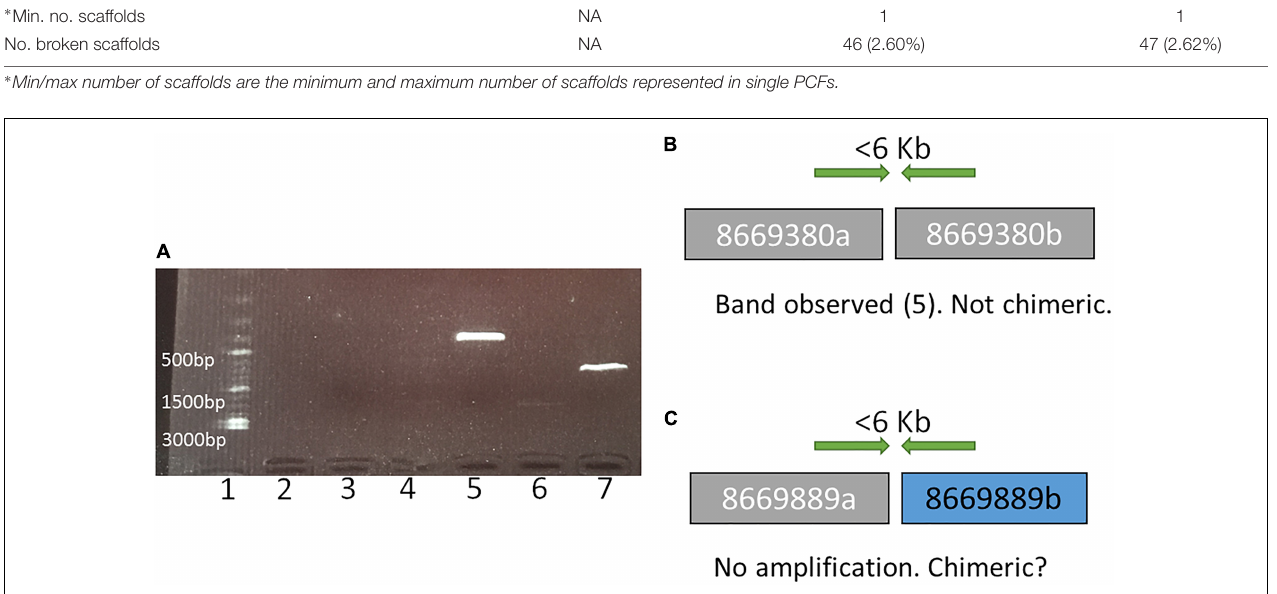
Frontiers in Genetics |